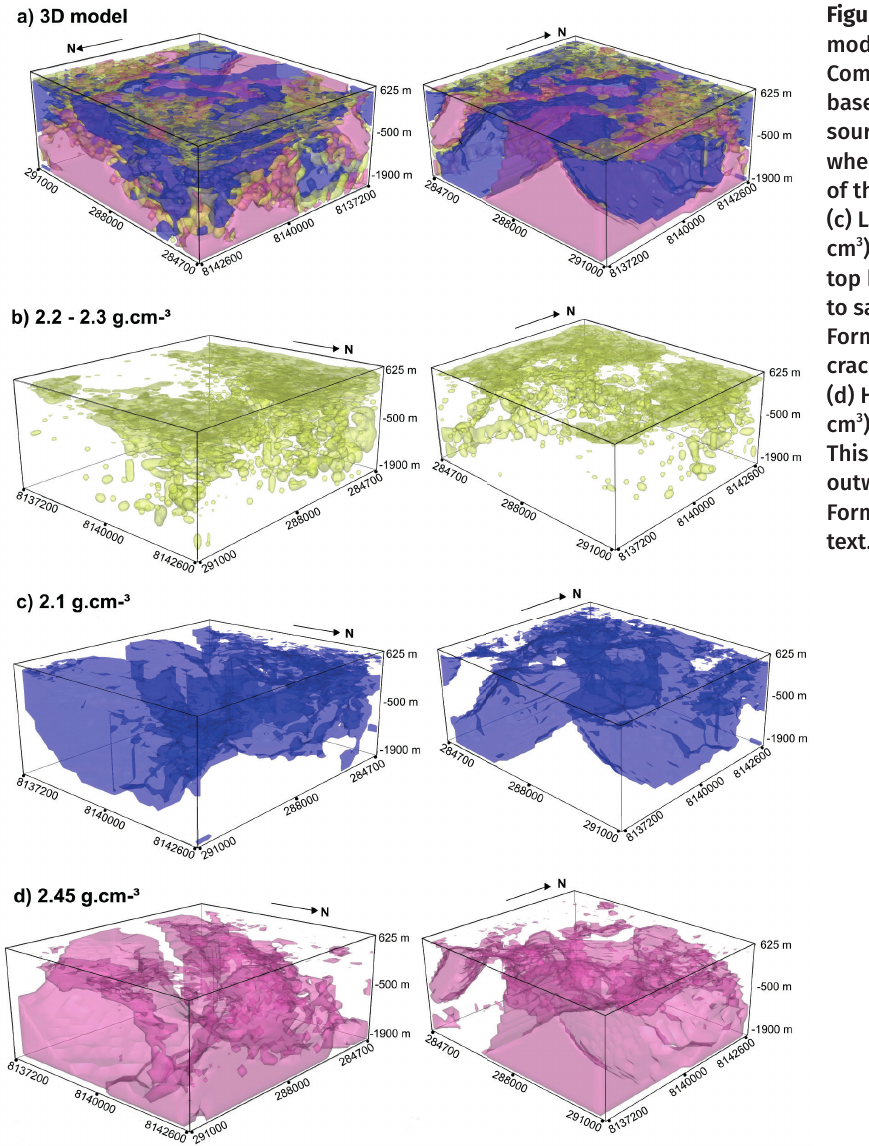
Figure 3. 3D gravity inversion model of the central uplift. (a) Complete model. From top to base: (b) Intermediate density sources (2.2 - 2.3 g/cm 3 ), likely where breccias and sandstones of the Furnas Formation